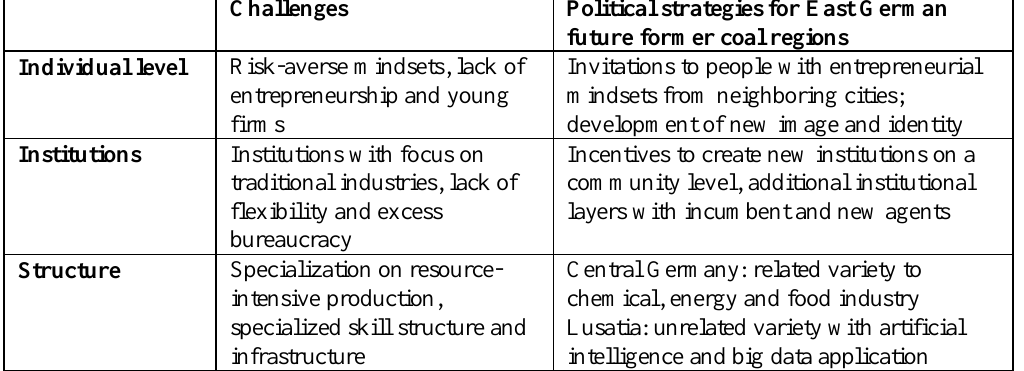
Table 3: Political Strategies to Overcome Barriers to Transformation in East German Future Former Coal Regions Challenges Political strategies for East German future former coal regions Invitations to people with entrepreneurial Individual level Risk-averse mindsets, lack of entrepreneurship and young mindsets from neighboring cities; firms development of new image and identity Incentives to create new institutions on a Institutions Institutions with focus on traditional industries, lack of community level, additional institutional flexibility and excess layers with incumbent and new agents bureaucracy Central Germany: related variety to Structure Specialization on resource- intensive production, chemical, energy and food industry specialized skill structure and Lusatia: unrelated variety with artificial infrastructure intelligence and big data